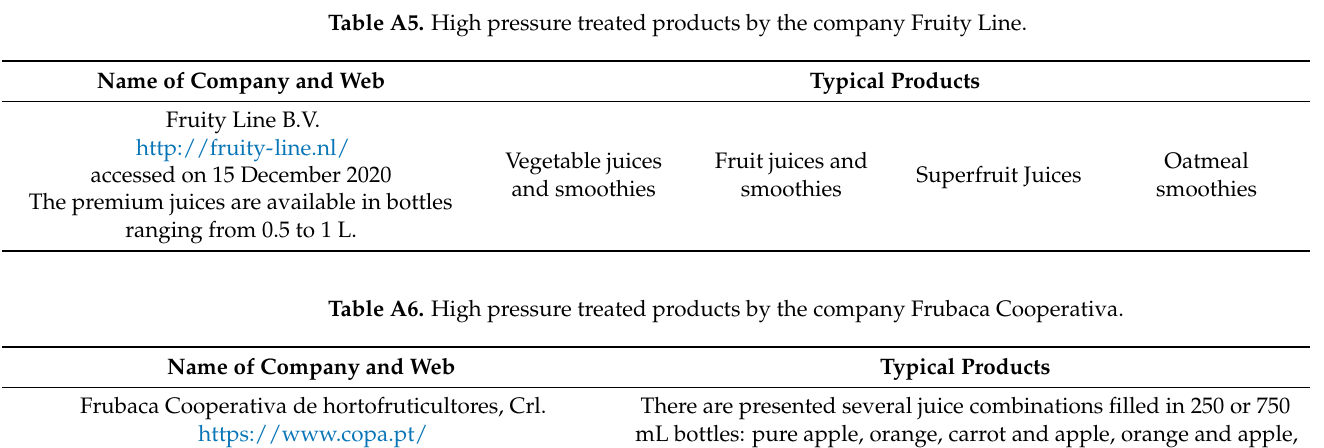
Table A4. High pressure treated products by the company Evolution Fresh.